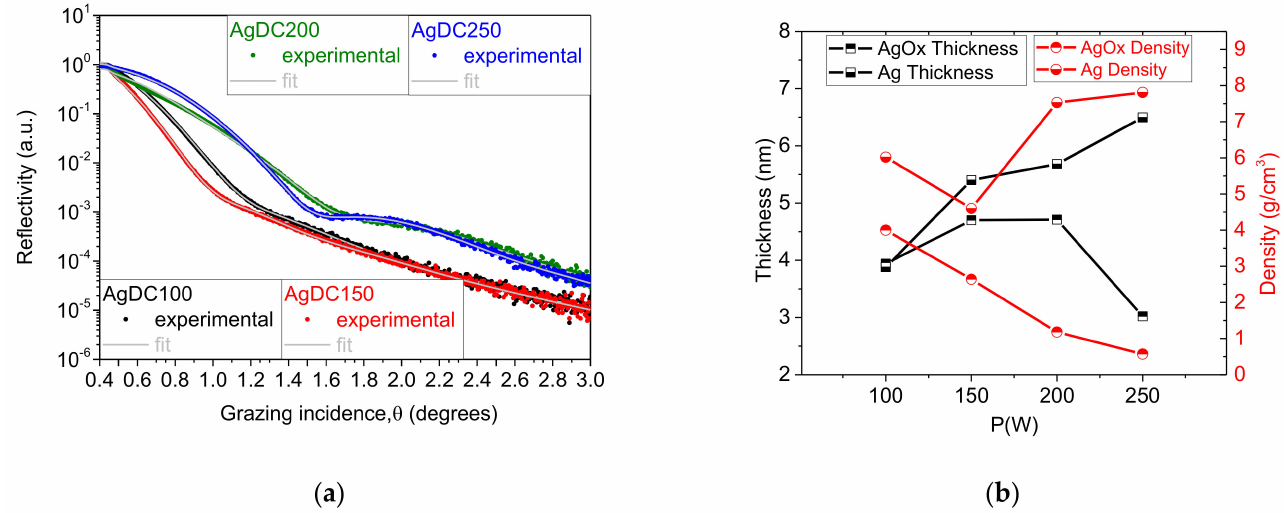
Figure 7. XRR spectra of Ag thin films deposited at 4 power settings of DC (scattering), and the fitting of the spectra (full line) ( a ); along with the resulted density and thickness variation as a function cathode power fed (the error bars are within symbol limit) ( b